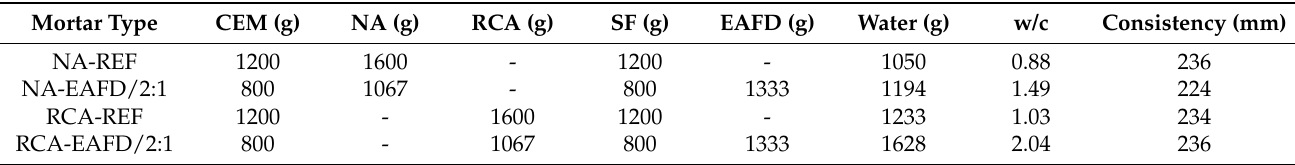
Table 5. Mortar mix